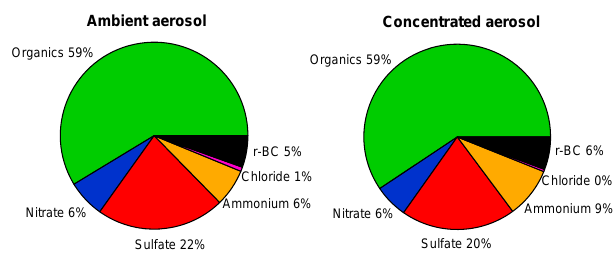
Figure 6. Average chemical composition of ambient and concen- trated particles measured with the SP-AMS laser